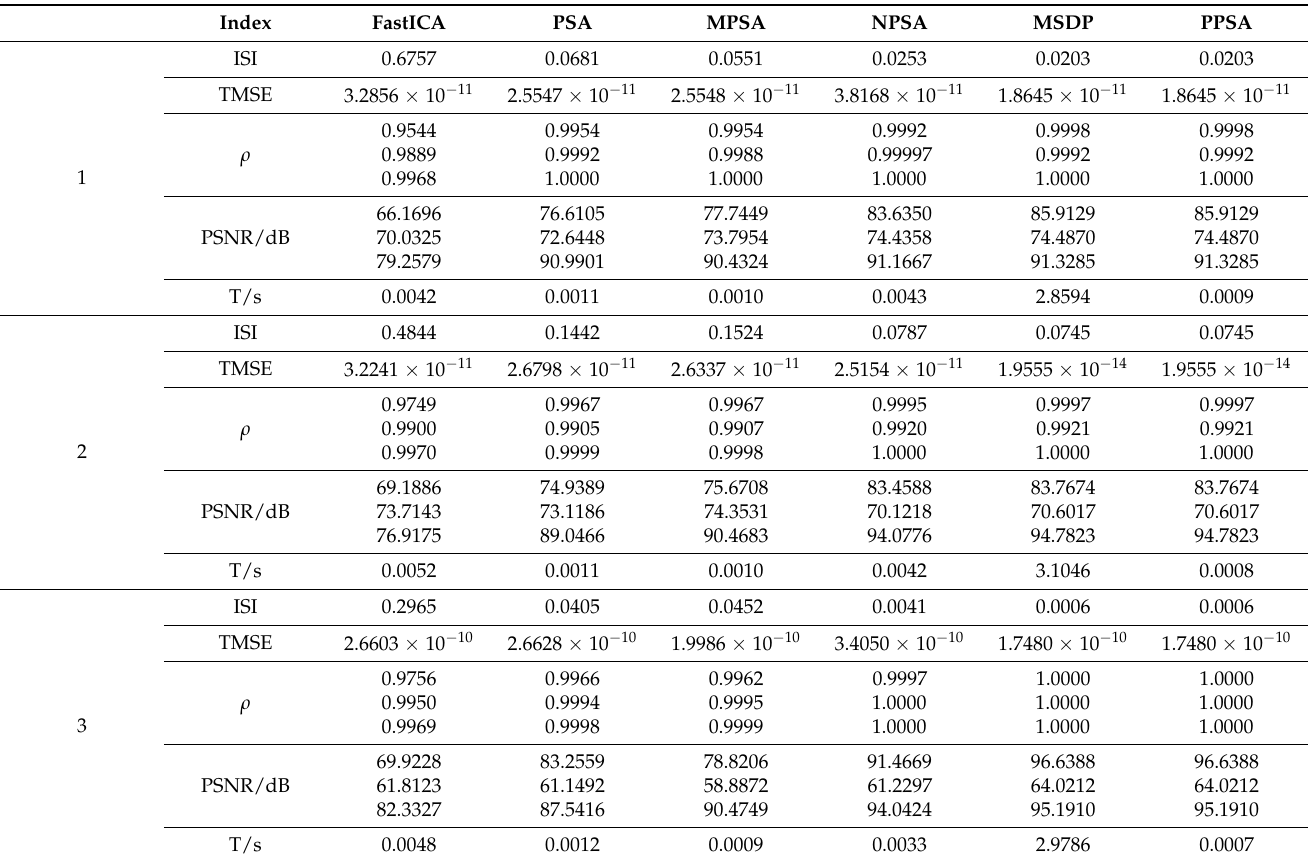
Table 1. Comparison of FastICA, PSA, MPSA, NPSA, MSDP and PPSA for the index of five different combinations. An average result of the runs is computed.